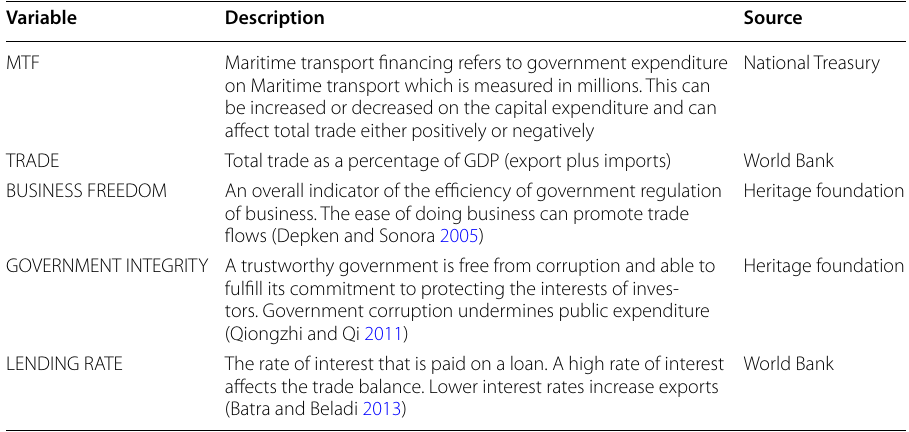
National Treasury Heritage foundation